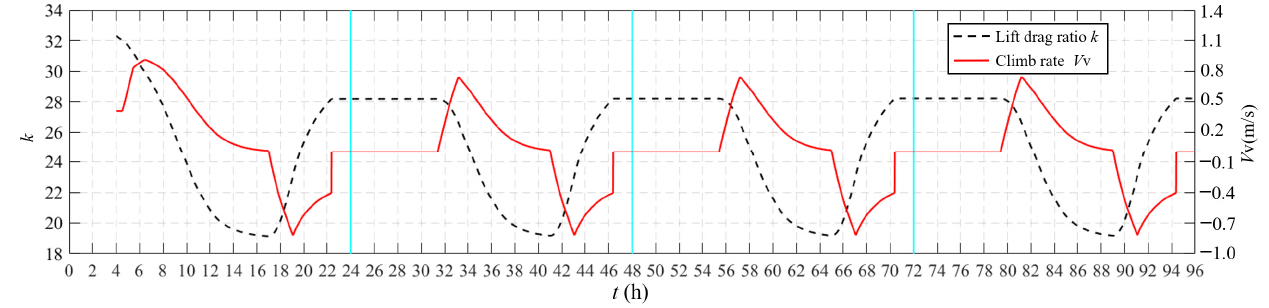
Figure 19. Climb rate of typical flight profile.